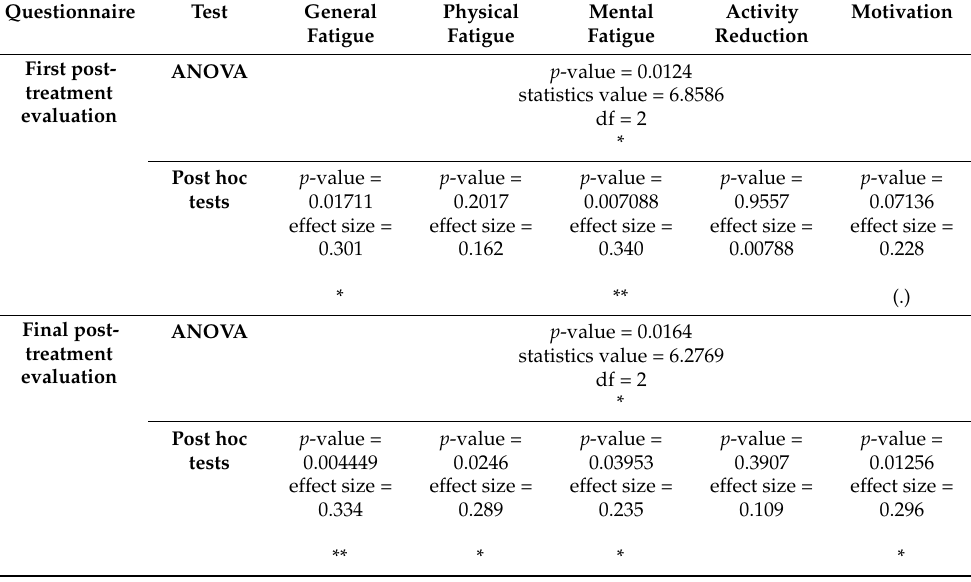
Table A6. Statistical tests performed after baseline correction to compare the hippotherapy and control groups, in order to assess the difference in score evolution for all the MFI-20 items, at first post-treatment evaluation and final post-treatment evaluation. A robust between–within participants ANOVA was performed to evaluate as to whether the two therapies followed a different behavior with respect to the MFI-20 items, for each questionnaire (Q2 and Q3). If significant, post hoc tests (two-sided Wilcoxon) were performed for each item to determine statistical differences between the two groups. (.) close to significance (between 0.08 and 0.05); (*) p < 0.05; (**) p <